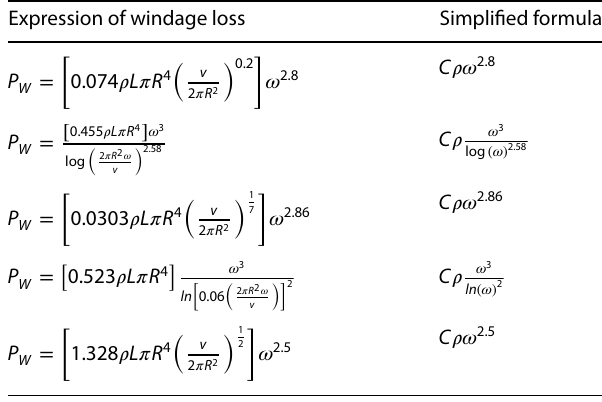
Table 3 Available calculation formulae for windage